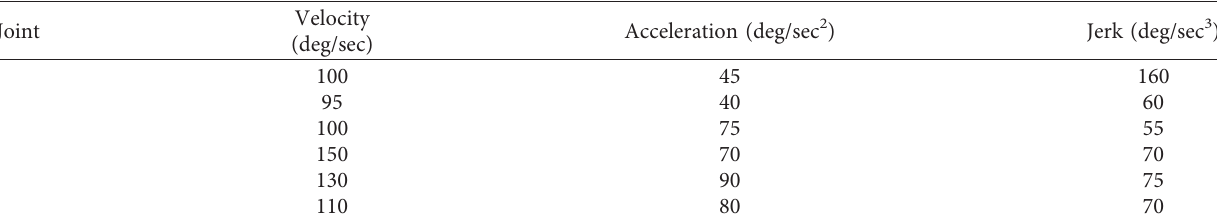
Table 2: Upper limits of different constrains for each joints.